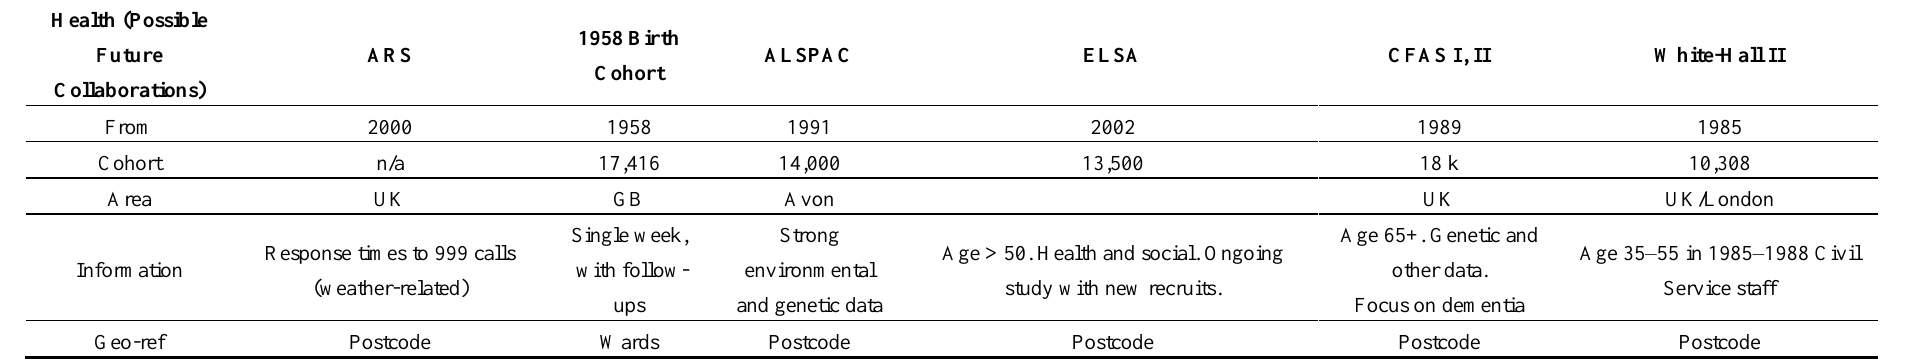
Table 4. Summary table of potential health databases the MED MI Partnership has identified, as well as other databases for potential future collaborations (more details at